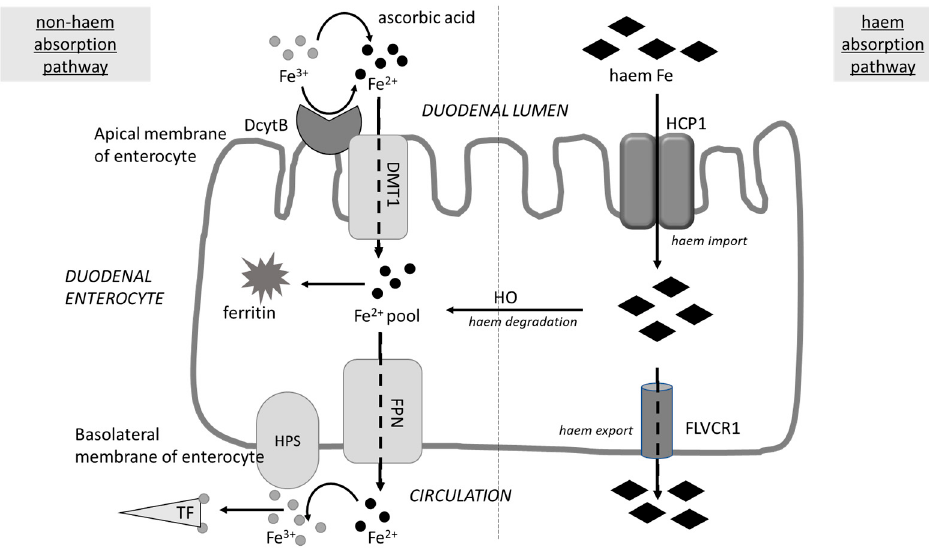
Figure 2. Possible pathways of iron absorption through the duodenal enterocyte based on [161,168,169]. Abbreviations: Fe 3+ —ferric iron, Fe 2+ —ferrous iron, DcytB—duodenal cytochrome